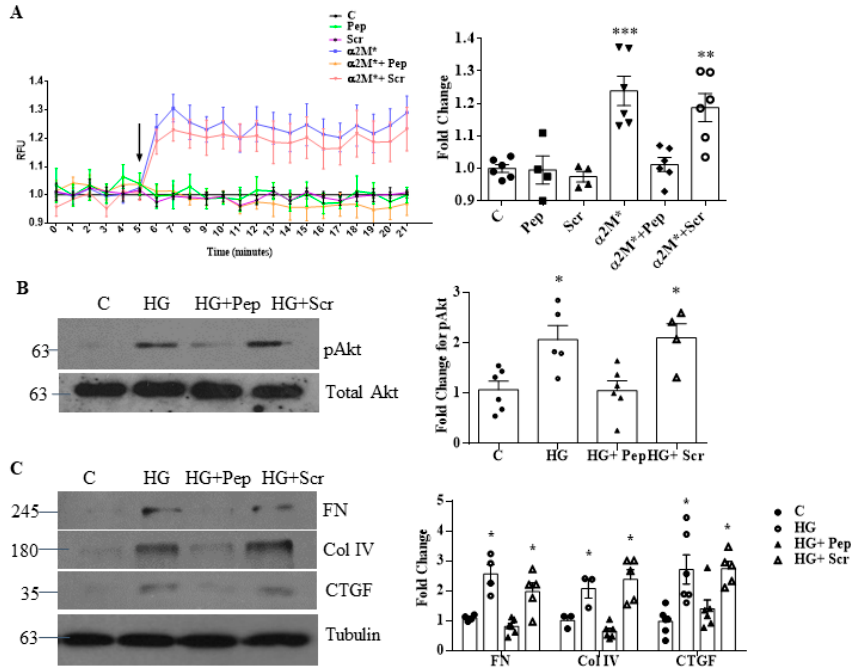
Figure 4. An α 2M* blocking peptide inhibits HG-induced profibrotic responses. ( A ) The peptide (Pep) blocking csGRP78/ α 2M* interaction, but not a control scrambled (Scr) peptide (both 100 nM), inhibited release of intracellular calcium stores in response to α 2M* (100 pM, 15 min) in 1-LN cells ( n = 6, * p < 0.01, ** p < 0.05 or *** p < 0.001). ( B , C ) MCs were treated with high glucose (HG, 48 h) with or without peptides as in ( A ). The inhibitory peptide, but not the scrambled peptide, prevented HG-induced Akt activation ( B ) and upregulation of matrix proteins fibronectin (FN) and collagen (Col) IV and of the profibrotic cytokine CTGF ( n = 5, * p < 0.01 vs. control and HG with peptide).